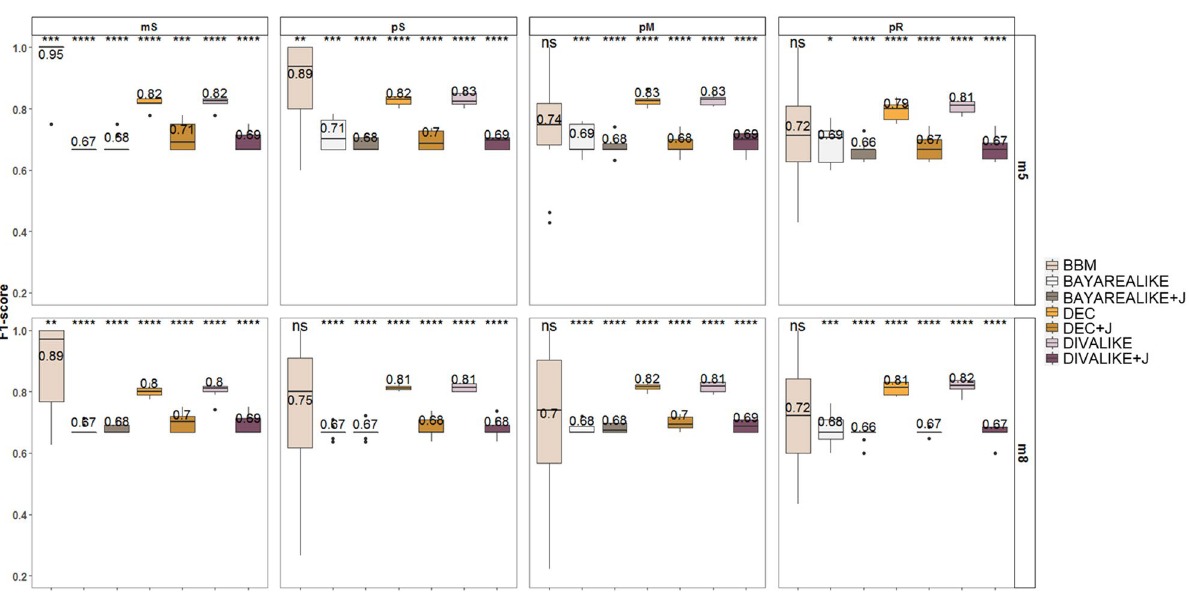
Figure 5. Performance of the seven biogeographic models in inferring clone migrations as measured by F1-scores. Mean values are shown above the box plots. Accuracies are shown based on the number of tumors within datasets (5–7 tumors for m5 and 8–11 tumors for m8) and on the complexity of migration schemes within datasets (monoclonal single- source seeding, mS; polyclonal single-source seeding, pS; polyclonal multisource seeding, pM; polyclonal reseeding, pR). Differences in values of F1-score on tumor count and seeding scenario were examined through t-test and are marked when significant (*, **, ***,